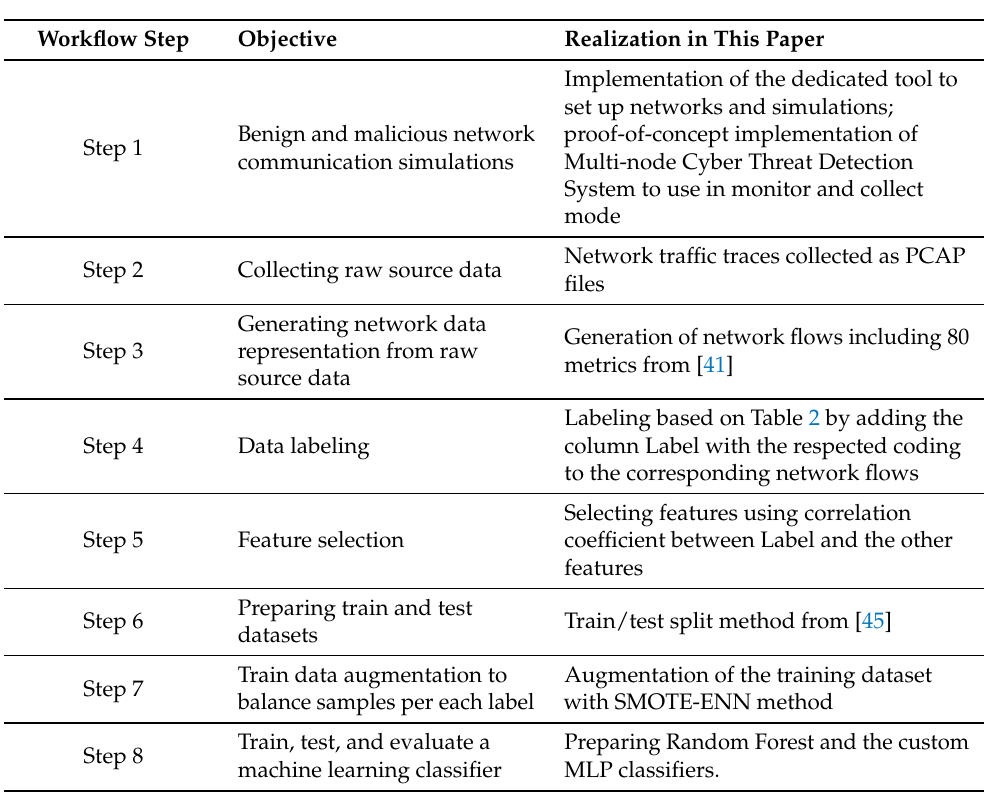
Table 9. Summary of realized actions per each step of generic procedure to research cyber threat detection